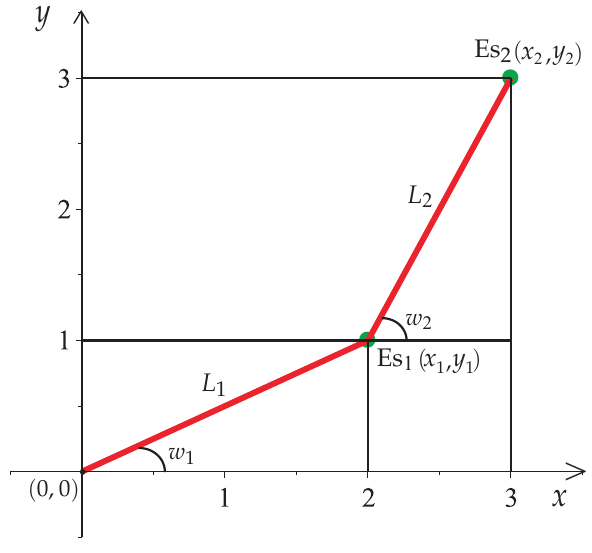
Figure 5. Representation of a two-link planar robot